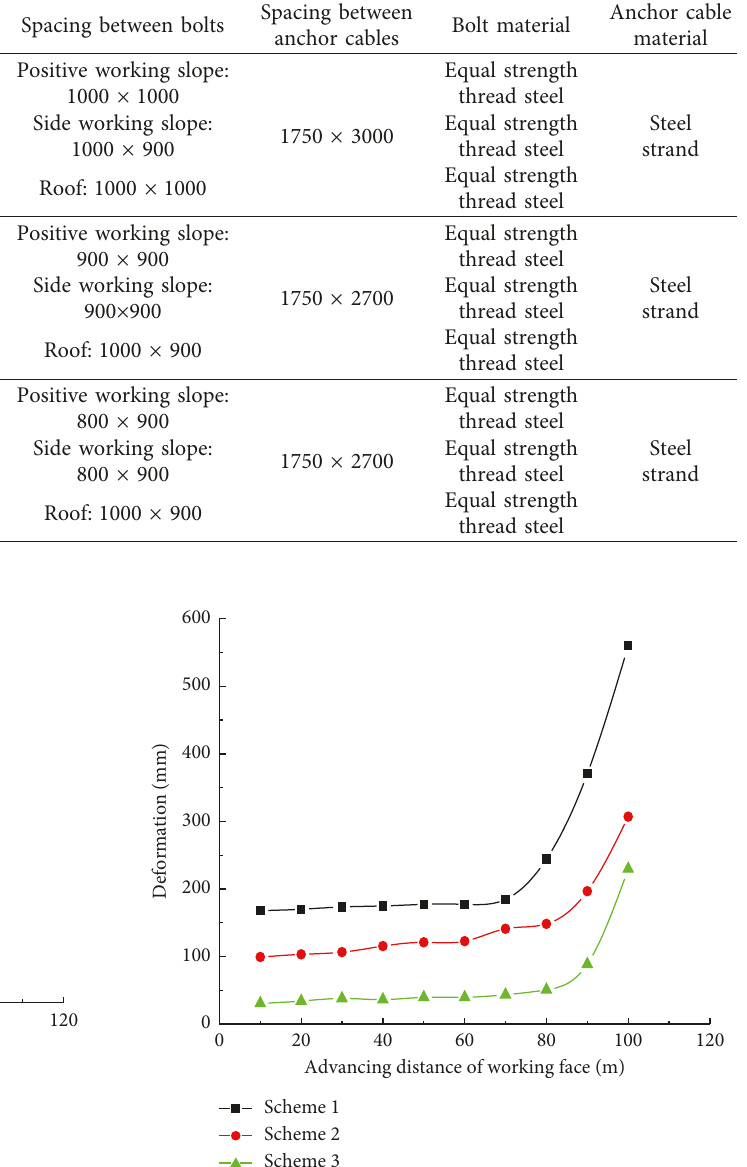
Figure 8: Assistant retracement channel: minor wall